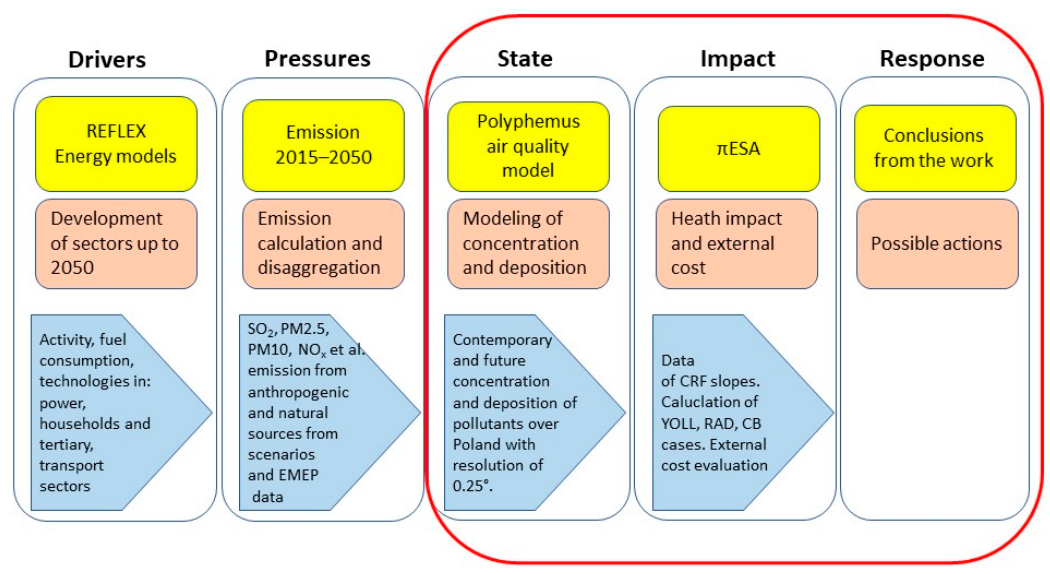
Figure 1. The Driver-Pressure-State-Impact-Response (DPSIR) framework, tools, data flow, and scope of the works. The red frame contains the elements that were made for the purpose of this work. EMEP: European Monitoring and Evaluation Programme; YOLL: Years of Life Lost; RAD: Restricted Activity Days; CB: Chronic Bronchitis; PM10: particulate matter with particles with a diameter of less than 10 µ m; PM2.5: particulate matter with particles with a diameter of less than 2.5 µ m; π ESA: Platform for Integrated Energy System Analysis; CRF: concentration–response function.